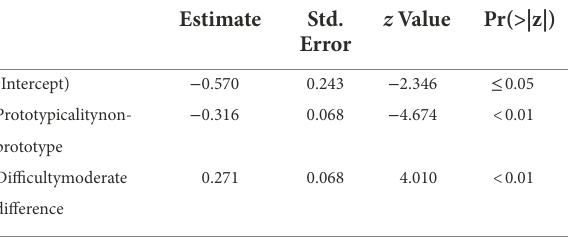
TABLE 3 Overview of the best-fitting model for the discrimination dataset in Experiment